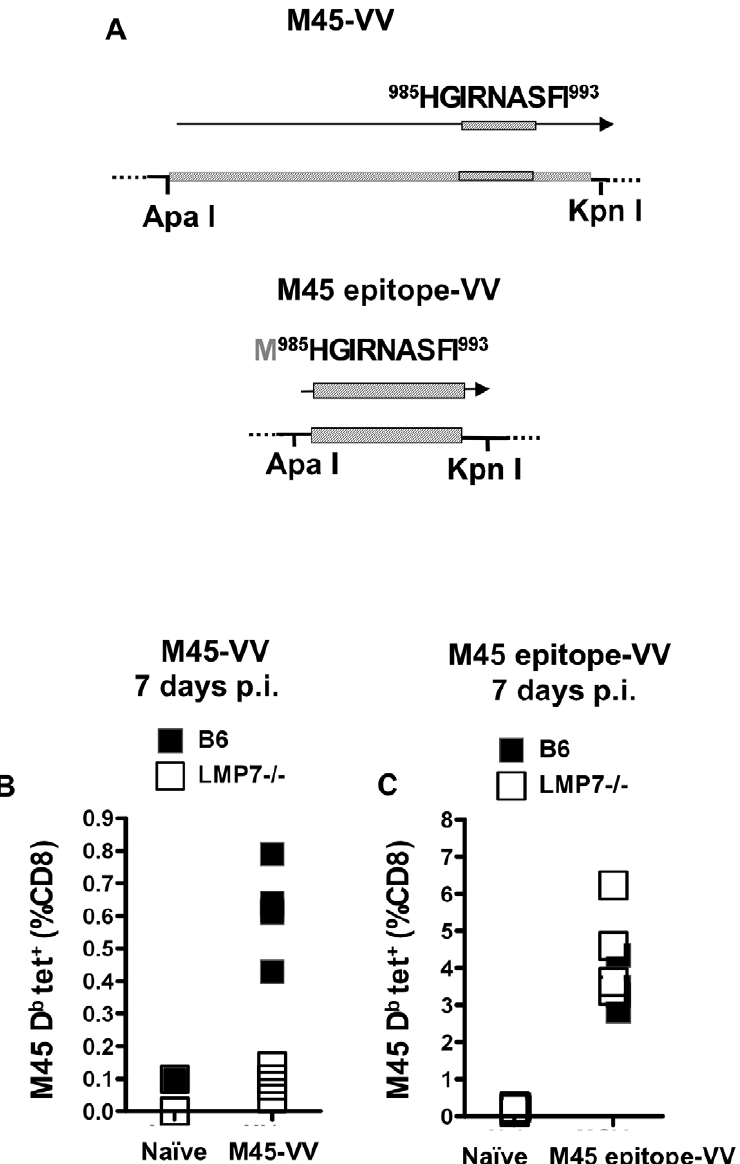
Figure 6. CD8 + T cell responses to M45 in LMP7 2 / 2 mice infected with M45-expressing rVV. A. Recombinant vaccinia viruses (rVVs) were constructed containing foreign genes derived from the genomic sequence of MCMV Smith Strain (ATCC VR-194). Foreign genes were full length gene encoding the MCMV protein M45 (M45-VV), or a ‘minigene’, encoding the antigenic fragment of M45 corresponding to the CD8 epitope M45 H-2 D b 985 HGIRNASFI 993 (M45 epitope-VV). Genes were designed for insertion between restriction sites for restriction endonucleases Apa I (5 9 ) and Kpn I (3 9 ). The diagram shows recombinant genes and proteins encoded by the two rVVs used in this study: M45 VV encoding full-length M45; and M45 epitope-VV, encoding the minimal D b -restricted CD8 epitope of M45 only. B, C. LMP7 2 / 2 or C57BL/6 control mice were injected i.v. with 1 6 10 6 pfu M45-VV (B), 1 6 10 6 pfu M45epitope-VV(C)oranequivalentvolumeofPBS.Bloodwassampled7daysp.i.bytailbleed.Peripheralbloodlymphocytesweresubjectedtotetramerstain with M45 D b HGIRNSFI tetramer and FACS analysis as for Figure 1A. The frequency of cells specific for M45 H-2 D b 985 HGIRNASFI 993 among CD8 + T cells in the blood of MVacc and MGVacc - infected and mock-infected C57BL/6 and LMP7 2 / 2 mice, 7 days after infection, is